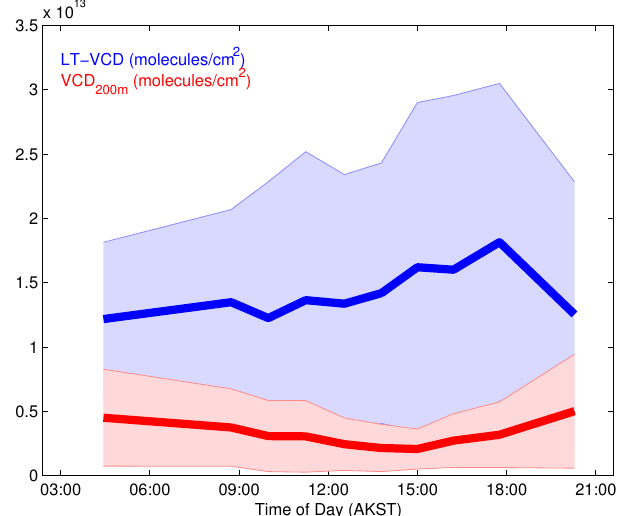
Figure 12. The diurnal cycling of the BrO LT-VCD (blue) and VCD 200m (red). The solid lines represent the mean VCD as a func- tion of time of day, while the shaded region represents 1 standard deviation. The shaded regions are symmetric about the mean in both cases; however, the cycling of the VCD 200m is overlain on the cy- cling of the LT-VCD, partially obscuring the standard deviation of the